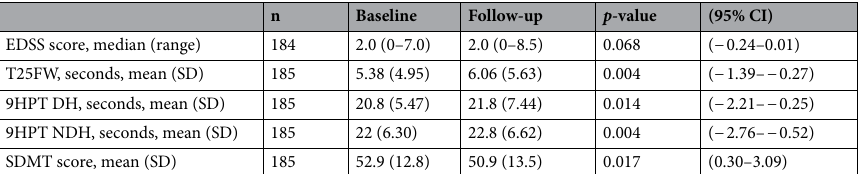
Table 2. Disability scores during the study. p -values and 95% confidence intervals (CI) from paired sample t-test to compare outcome scores between baseline and follow-up. The SDMT score was the raw correct number of substitutions. EDSS Expanded Disability Status Scale; T25FW Timed 25-Foot Walk; 9HPT 9 Hole Peg Test; DH dominant hand; NDH non-dominant hand; SDMT Symbol Digit Modalities Test. One patient was excluded due to an unavailable EDSS score.